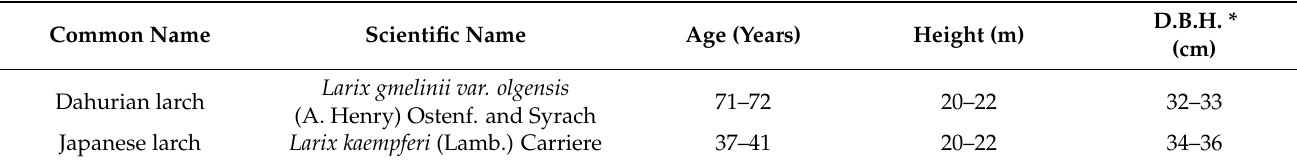
Table 1. Basic information on the sampled